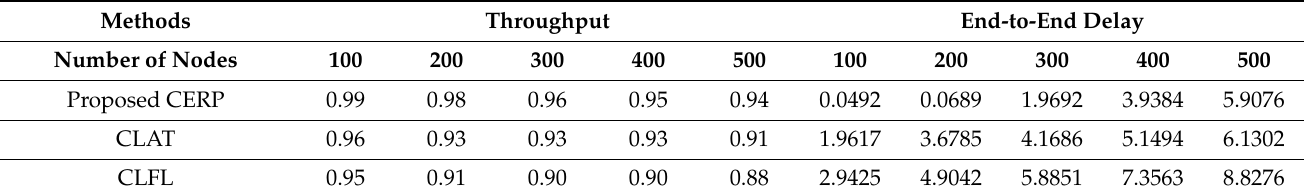
Table 5. Throughput and the end-to-end delay comparison.